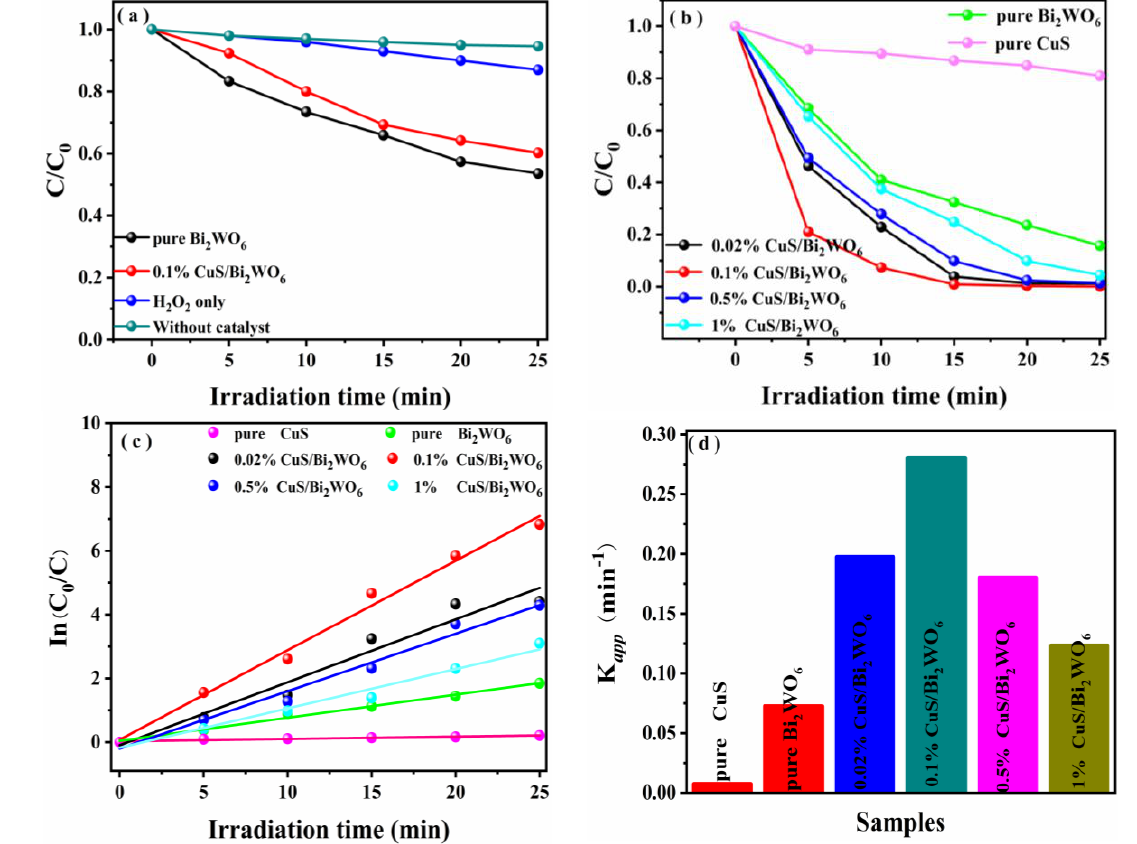
Figure 5. ( a ) The photo-catalytic degradation dynamic curves of RhB in the presence of pure Bi 2 WO 6 , H 2 O 2 only, without catalyst, and 0.1% CuS/Bi 2 WO 6 heterostructure. (Reaction conditions: T = 25 °C, concentration of RhB = 20 mg·L −1 , and catalyst concentration = 1 g·L −1 ). ( b ) The photo-Fenton catalytic degradation dynamic curves of RhB in the presence of pure Bi 2 WO 6 , CuS, and a series of CuS/Bi 2 WO 6 heterostructures. (Reaction conditions: T = 25 °C, the dosage of H 2 O 2 = 100 μ L, concentration of RhB = 20 mg·L −1 , and catalyst concentration = 1 g·L −1 ). ( c ) The pseudo-first-order reaction kinetics and ( d ) values of reaction rate constants over the synthesized samples in the photo-Fenton reaction.